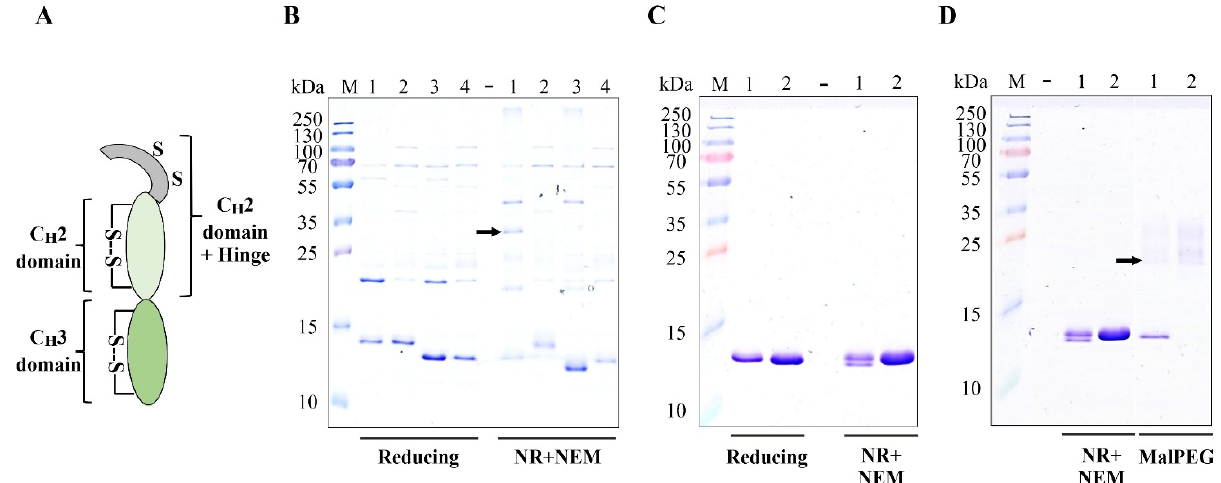
Figure 3. ( A ) Schematic representation of individual domains expressed to identify the cause of redox heterogeneity. ( B ) SDS ‐ PAGE gel image of IgG 1 C H 2 domain with and without hinge region expressed in the presence and absence of CyDisCo. A dimer can be observed (marked with an arrow) under non ‐ reducing (NR), NEM ‐ treated conditions for the IgG 1 C H 2 domain with hinge region (Lane 1) in the presence of CyDisCo corresponding to the intermolecular disulfide in the hinge region. M: protein marker, 1: IgG 1 C H 2 domain with hinge + CyDisCo, Lane 2: IgG 1 C H 2 domain with hinge–CyDisCo, Lane 3: IgG 1 C H 2 domain + CyDisCo, Lane 4: IgG 1 C H 2 domain–CyDisCo. ( C ) SDS ‐ PAGE gel image of the IgG 1 C H 3 domain expressed in the presence and absence of CyDisCo. The gel shows redox heterogeneity for the IgG 1 C H 3 domain in the presence of CyDisCo under non ‐ reducing (NR), NEM ‐ treated conditions. M: protein marker, Lane 1: + CyDisCo, Lane 2:– CyDisCo. ( D ) MalPEG ‐ 5K (0.25 mM) assay to ascertain the redox state of IgG 1 C H 3 domain produced in the presence and absence of CyDisCo. Mobility shift observed due to MalPEG binding has been marked with an arrow. M: protein marker, Lane 1: + CyDisCo, Lane 2:– CyDisCo.